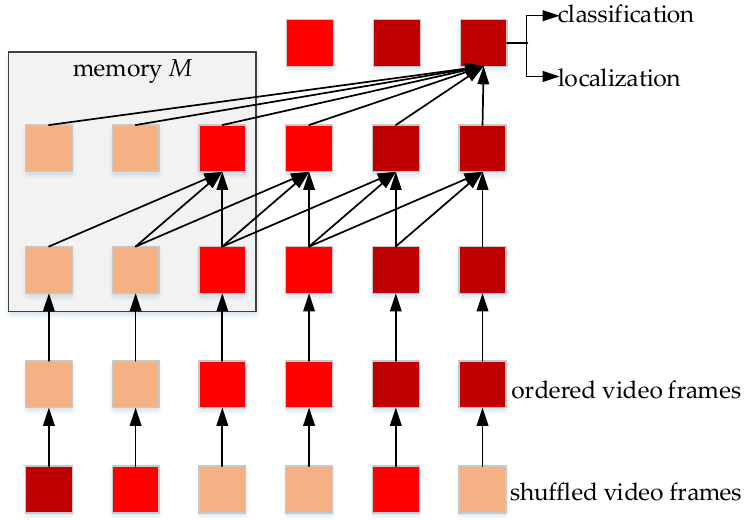
Figure 26. The illustration of MEGA. The arrows denote the directions of the aggregation. The depth of the color indicates the sequence.